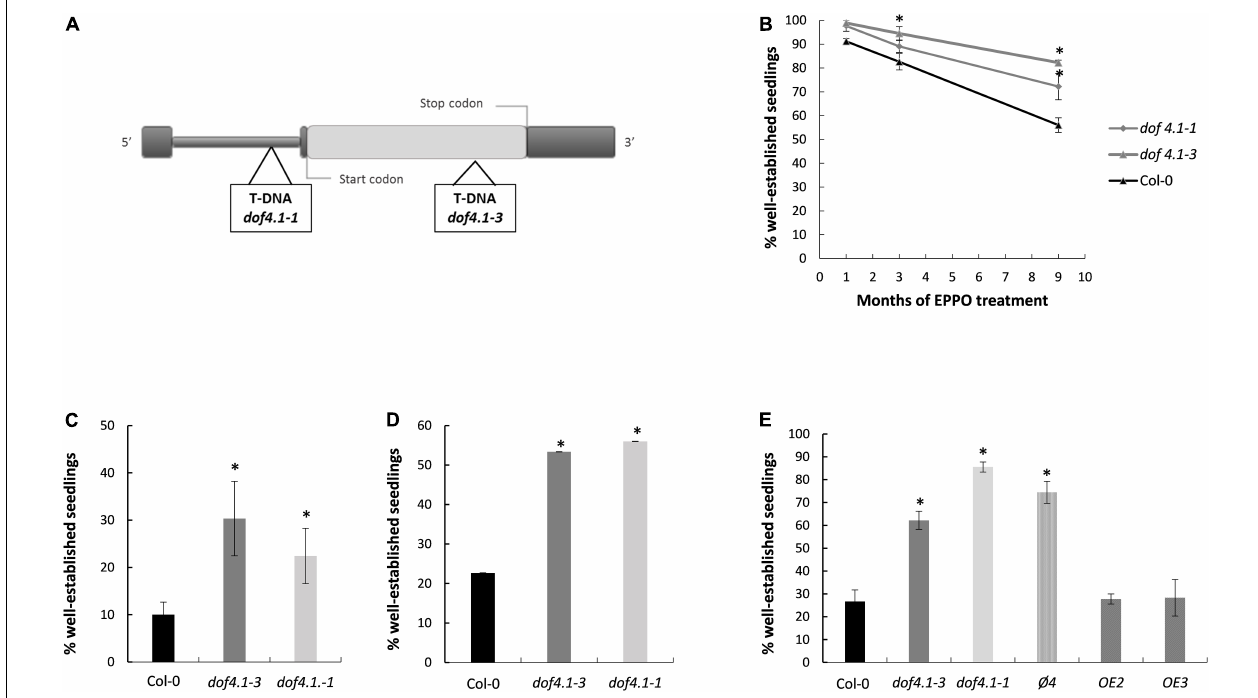
FIGURE 1 | dof4.1 seeds exhibit increased longevity. (A) Scheme of DOF4.1 locus showing the localization of T-DNA insertions in dof4.1-1 and dof4.1-3 alleles. (B) Elevated Partial Pressure of Oxygen (EPPO) treatment: Seeds were sown on MS plates after maintaining them during 1, 3, or 9 months at 5 bar O 2 and 10% RH. (C) Accelerating Aging Treatment: seeds were imbibed in water and incubated at 40 ◦ C for 36 h. (D) Natural seed aging treatment: dry seeds were maintained at room temperature and ambient humidity (20–25 ◦ C, 40–60% RH) for 18 months and sown on MS plates. (E) Accelerated aging treatment in dof4.1-3 lines overexpressing DOF4.1 under the control of pUBQ10 promoter. Seeds were imbibed in water and incubated at 40 ◦ C for 36 h. Percentage of established seedlings was recorded after 9 days growing on MS media. Bars represent the average and standard errors of three replicates with 50 seeds per line. Col-0, Columbia 0. ϕ 4: Transgenic plant transformed with the empty pUBQ10 vector used to generate the overexpression lines. OE: overexpression lines. Asterisks indicate significant differences with WT ( P < 0.05) between samples in two-tailed Student’s t -test.